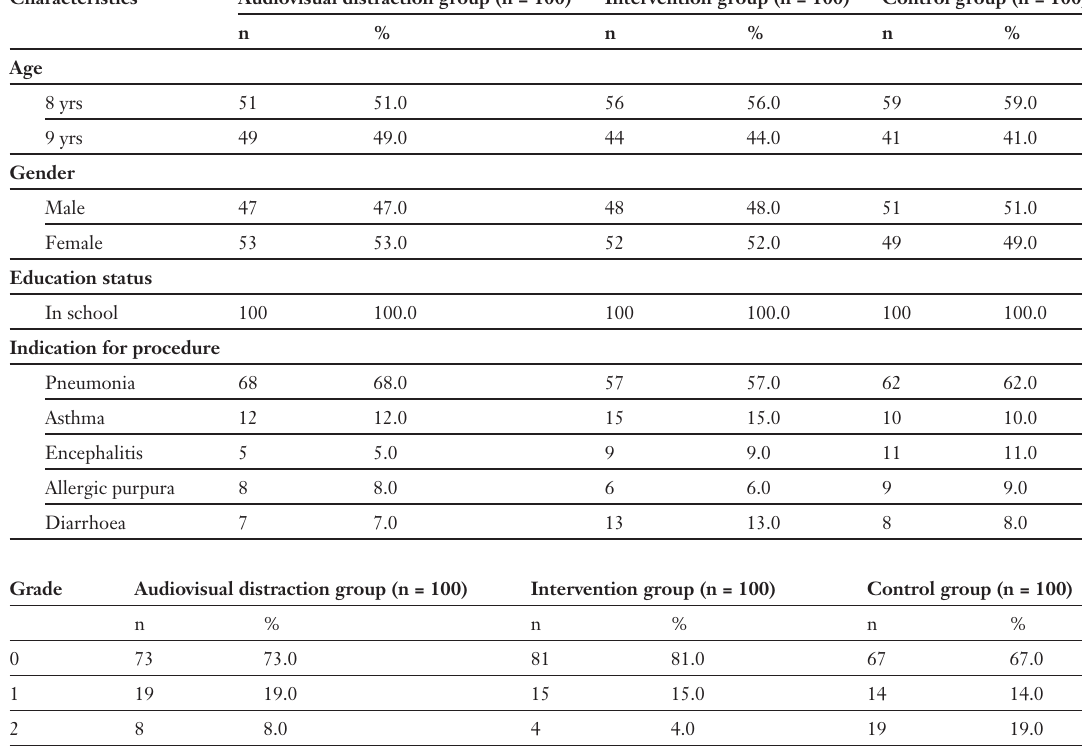
* CBSCV: cooperative behaviour scale of children in venepuncture